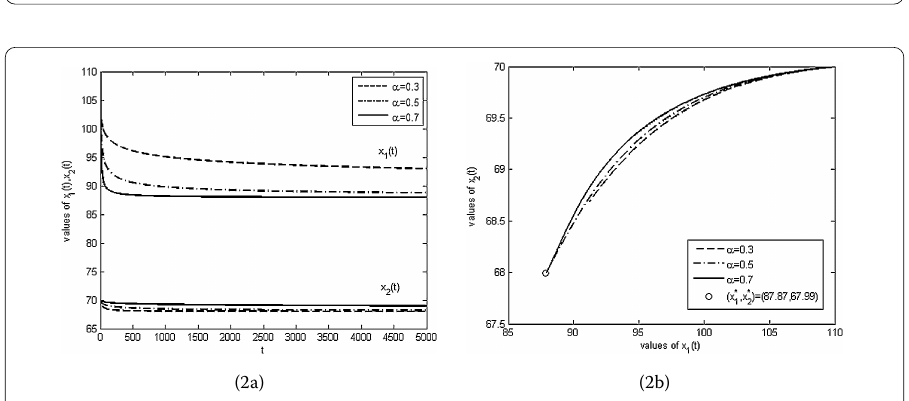
Figure 1 (1a) The relationship between the numbers of individuals of species x 1 , x 2 with respect to time t . (1b) The relationship between the values of x 1 and x 2 with α = 0.5 for ( x 1 (0), x 2 (0)) = (70,110), (90,90), and (110,70).